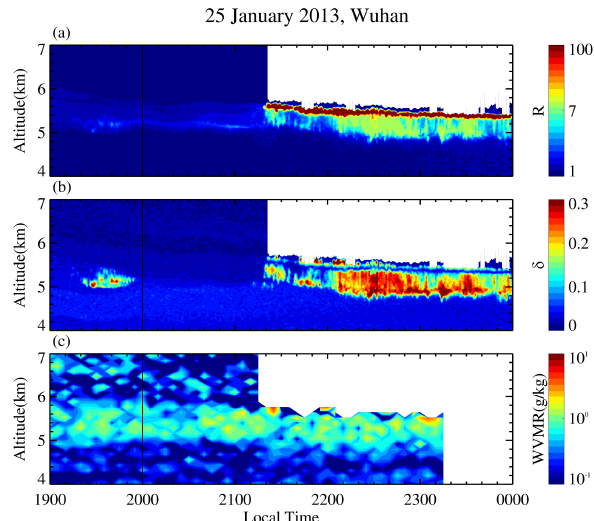
Figure 1. Time-height contour plots of backscatter ratio R ( a ), volume depolarization ratio δ ( b ) Figure1. Time-heightcontourplotsofbackscatterratioR( a ), volumedepolarizationratio δ ( b )measured measured by our 532-nm polarization lidar (1-min/30-m resolution), and the water vapor mixing ratio by our 532-nm polarization lidar (1-min / 30-m resolution), and the water vapor mixing ratio water vapor mixing ratio (WVMR) ( c ) measured by Raman Lidar (5-min / 120-m resolution) on 25 January 2013. The vertical line at 20:00 LT show the launch time of radiosonde from Wuhan Weather Station. Note that a liquid-layer-topped ice virga is visible from 21:20 to 23:59